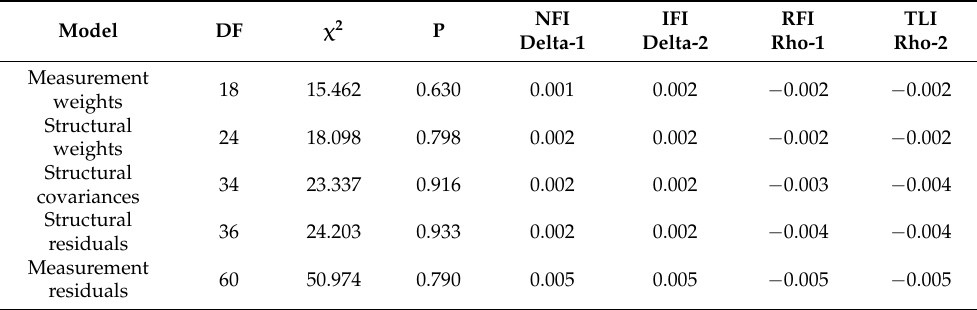
Table 8. Significance results of tested model compared with unconstrained